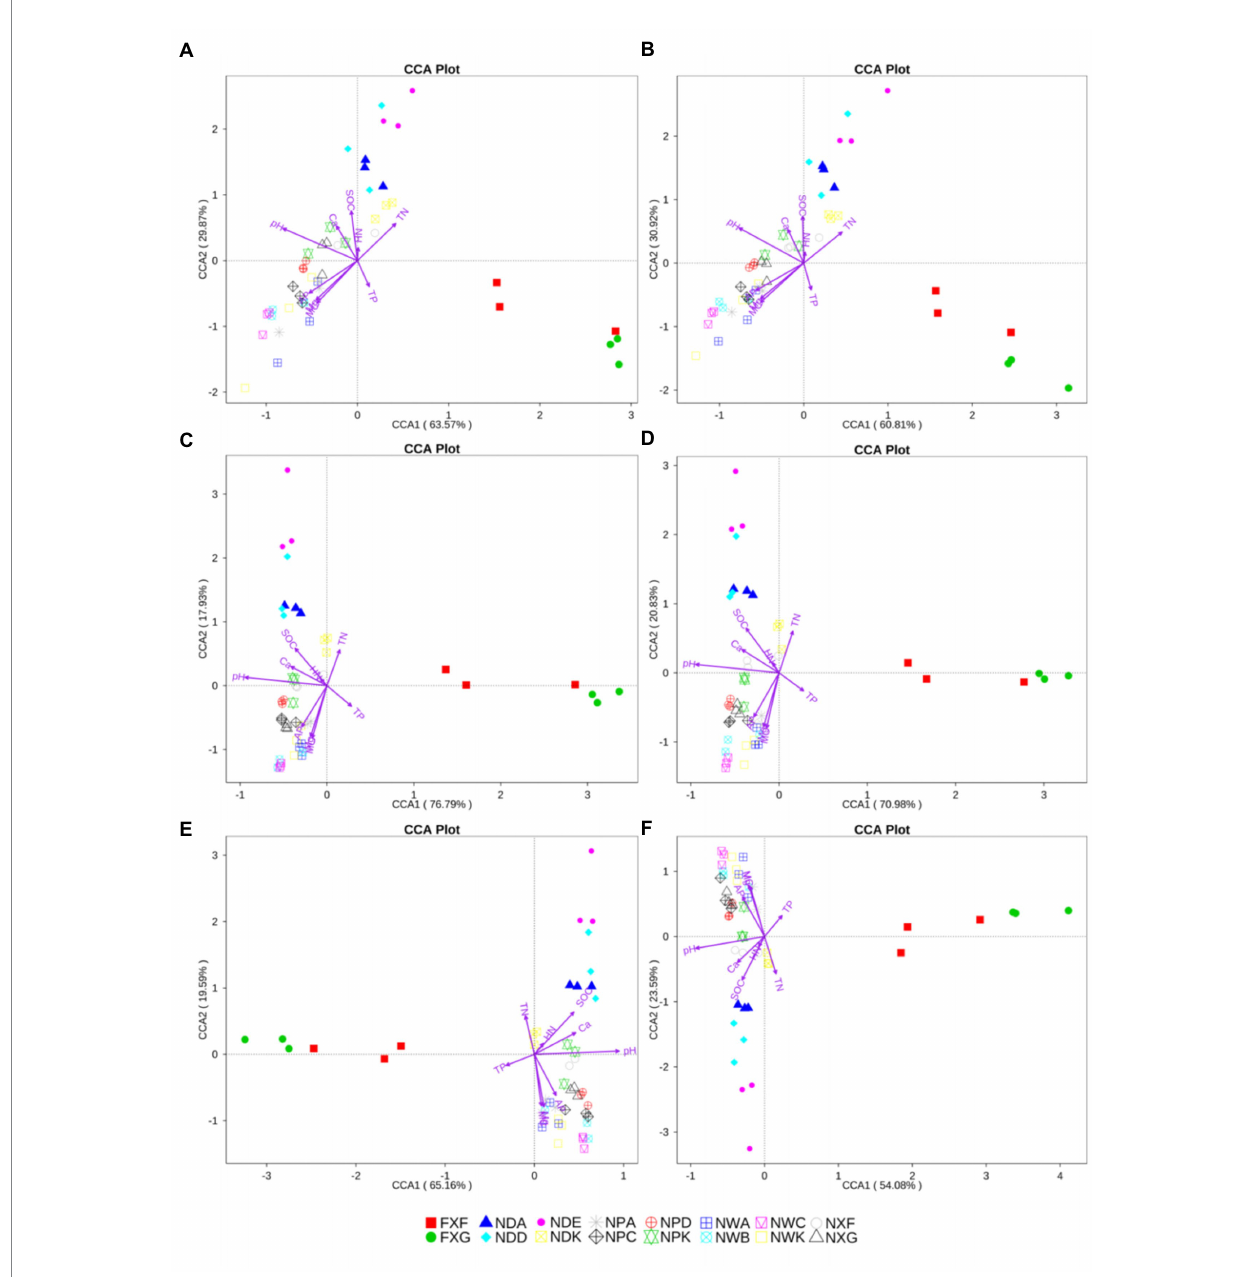
FIGURE 6 CCA analysis at the phylum (A) , class (B) , order (C) , family (D) genus (E) , and species (F) levels. The same symbols and colors indicated samples from the same group. Environmental parameters were demonstrated by purple arrows. The axes showed the percentages of variation in the distribution of microbe